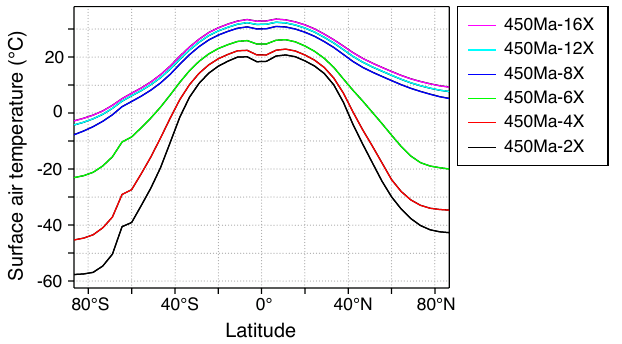
Figure 4. Mean annual, zonally averaged SAT simulated for each p CO 2 at 450Ma with the fully coupled version of FOAM.